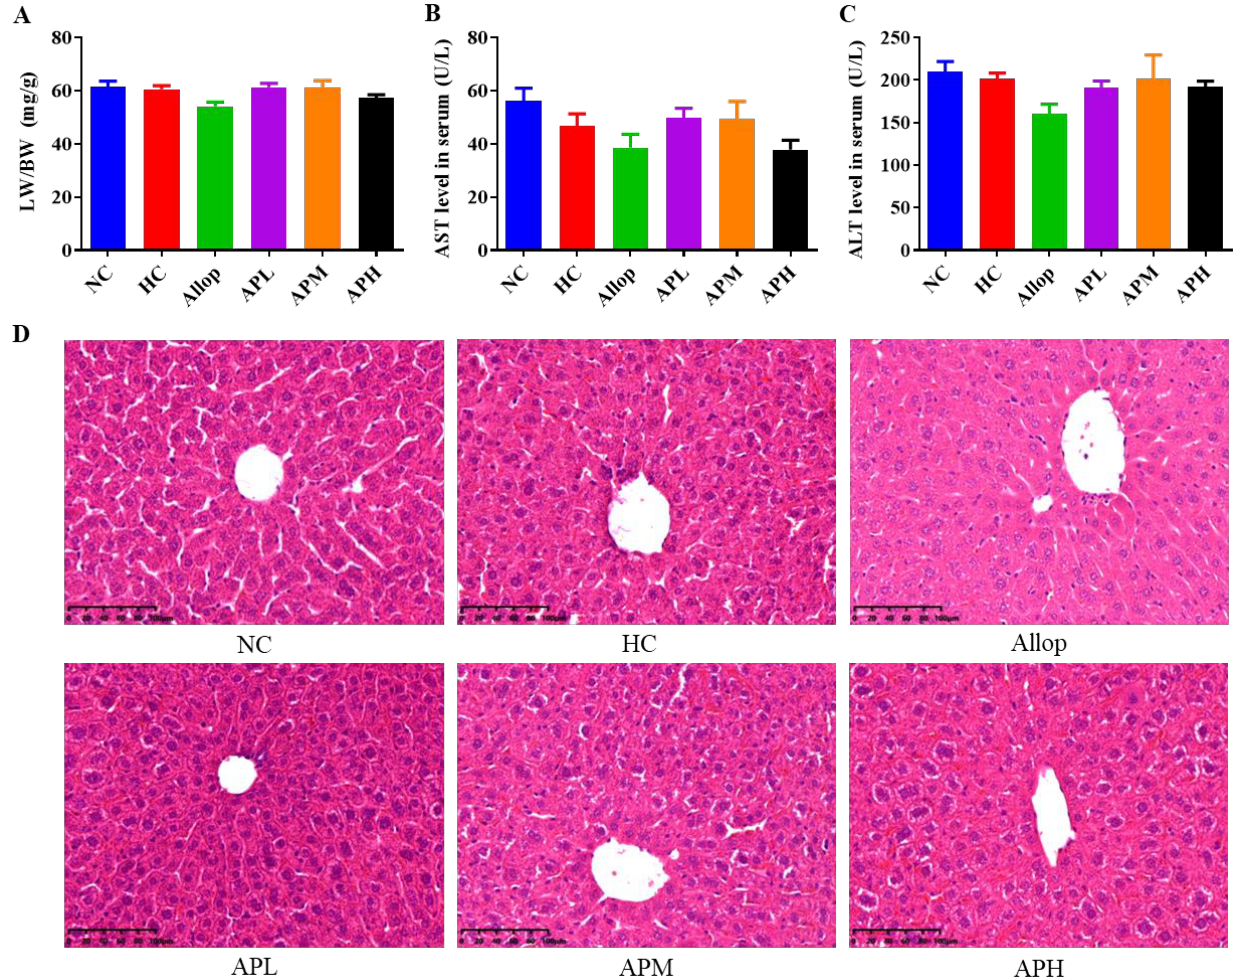
Figure 3. Apigenin has no effects on relative liver weight ( A ; mg/g, n = 10), serum levels of AST ( B ; U/L, n = 10) and ALT ( C ; U/L, n = 10), and pathological microstructures in HUA mice. Representative images of liver H&E staining ( D ; ×200, Scale bar: 100 μm).